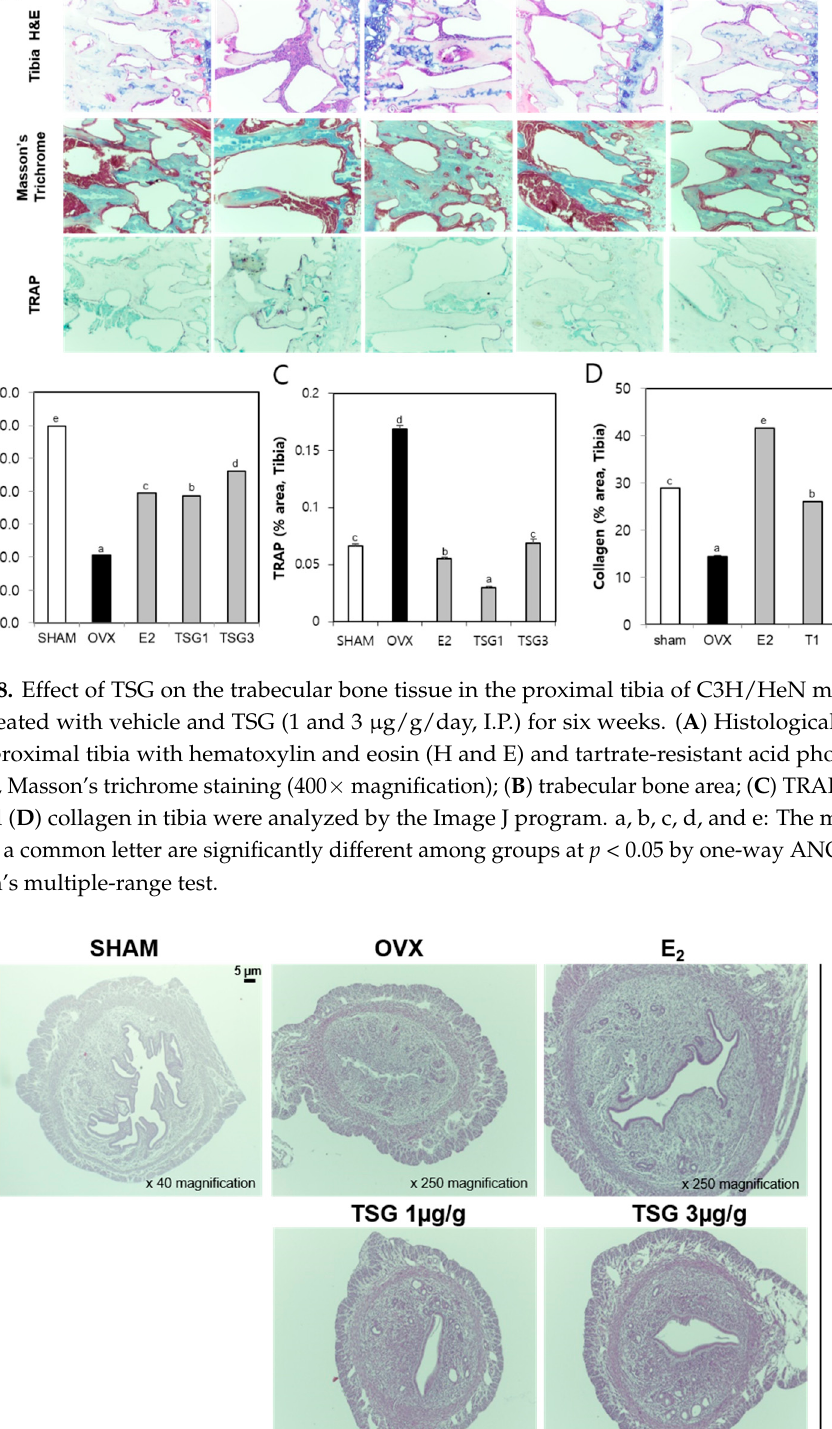
Figure 9. Effect of TSG on uterus tissue in C3H/HeN mice. Mice were treated with vehicle and TSG (1 and 3 μ g/g/day, I.P.) for six weeks. Histological changes in the uterus were performed via H and E staining.